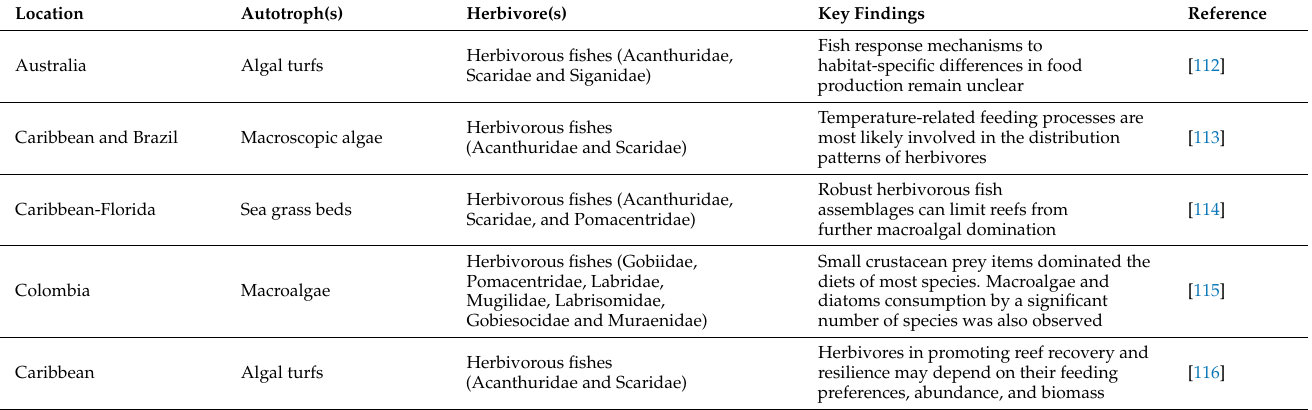
Figure 2. Conceptual model of macroalgae-herbivore-predator interaction. Table 2. Key findings in autotroph-herbivore studies conducted since 2000 .